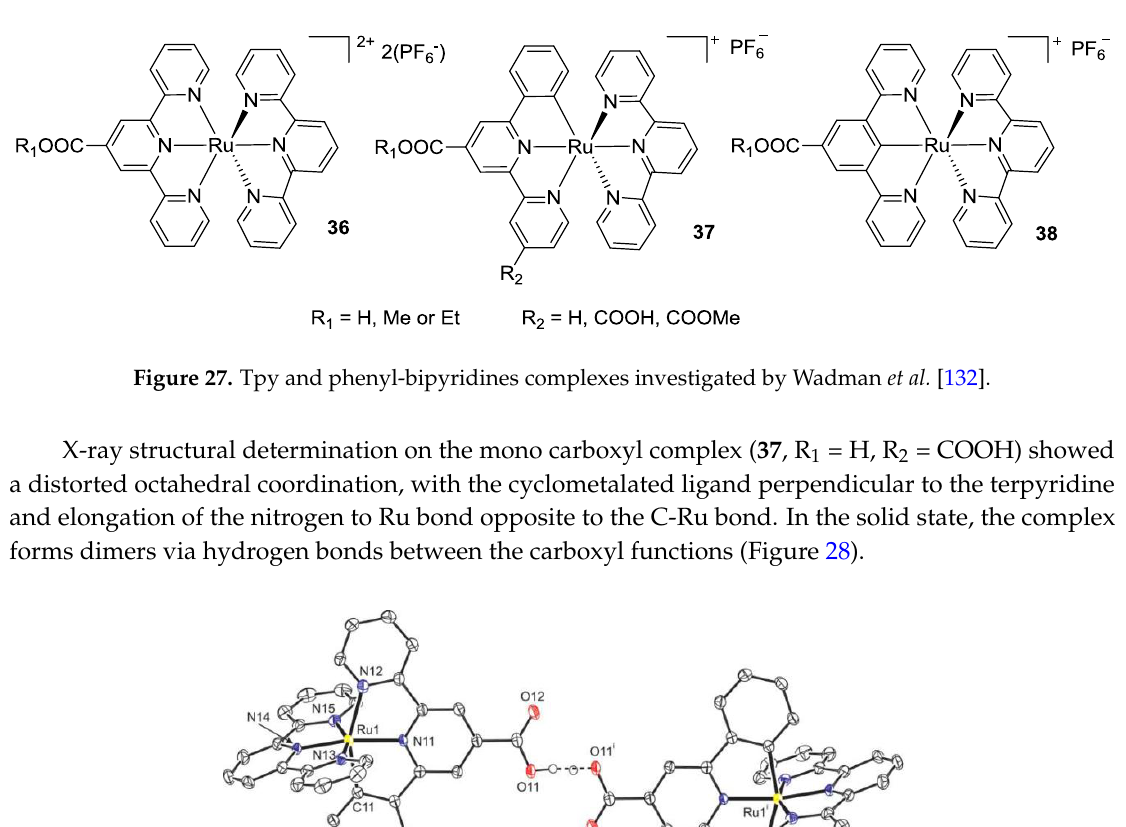
19 of 37 Figure 26. Pyridyl-pyrazolate ligand and quinolyl-bipyridine ligand for Ru(II)-complexes [22,127-129]. 3.2.6. Phenyl Bipyridines